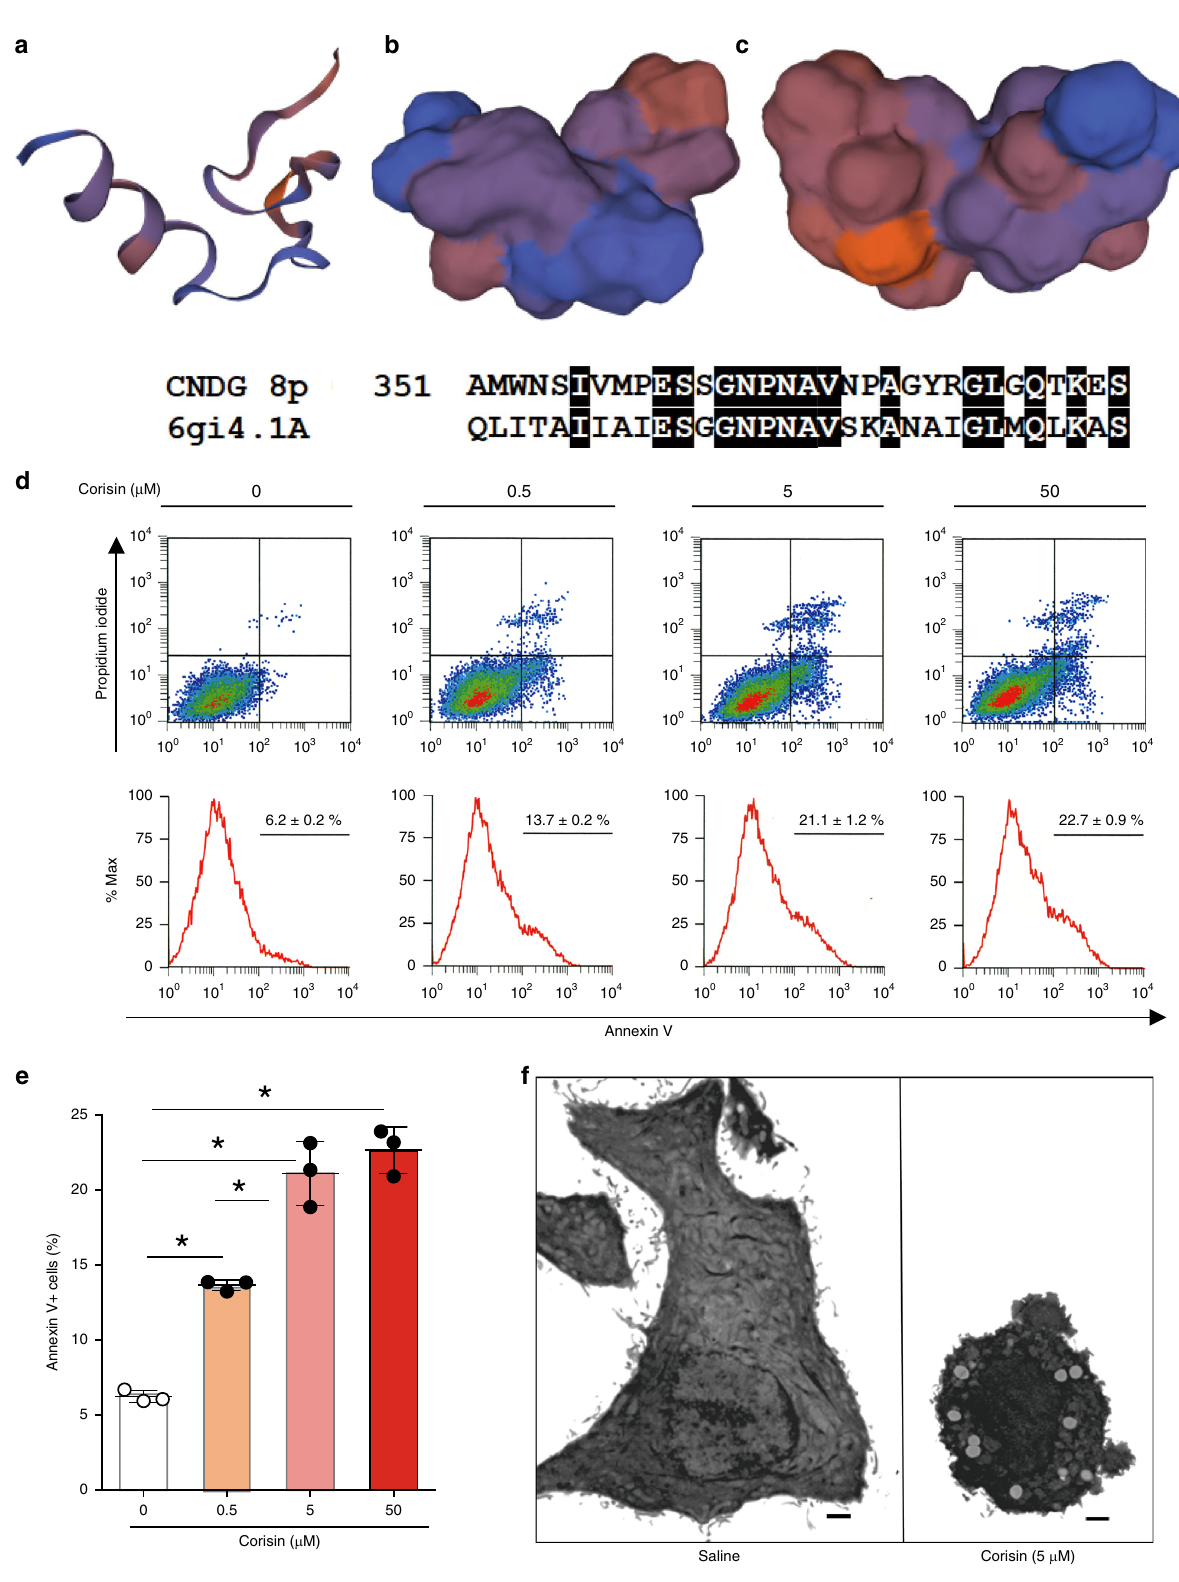
Fig. 21). The multiple alignment of the IsaA and the SceD amino acid sequences revealed, in general, conservation of amino acid residues representing the pro-apoptotic corisin, and thus high- lighting their functional signi fi cance (Supplementary Fig. 22).